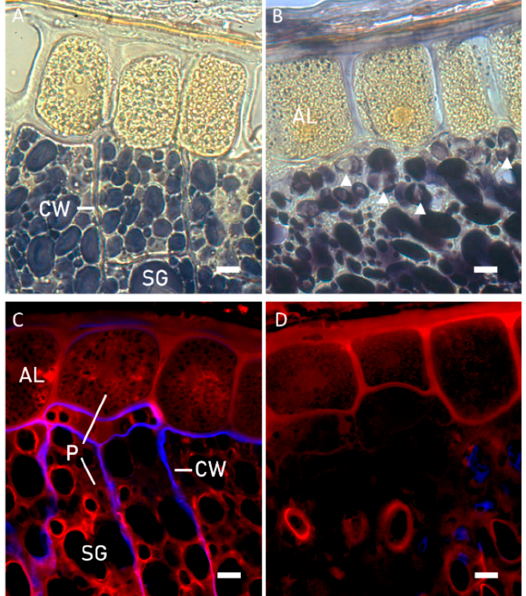
Figure 1. Light microscopy ( A , B ) and confocal laser scanning microscopy ( C , D ) of kernels before ( A – C ) and after ( B – D ) sprouting process. AL: aleuron layer, CW: cell wall, SG: starch granule, P: protein. White head arrows in panel B show hydrolyzed starch granules. Bars are 10 µ m in